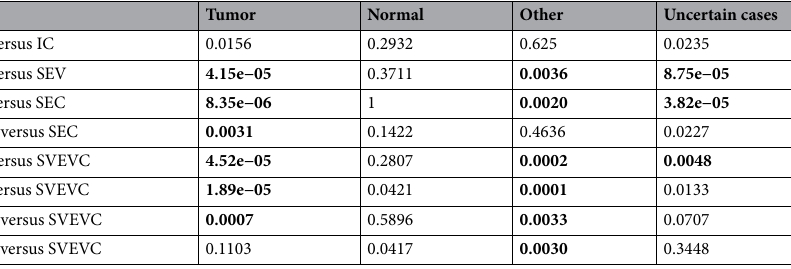
Table 2. The statistical p-value after testing the null hypothesis between different learning flows: IV, IC, SEV, SEC, and SVEVC considering three classes of TMA tissues and uncertain predictions in evaluation B. Using p values < 0.00625 as the statistically significant level of difference, we highlight the improvement of prediction cases in bold.